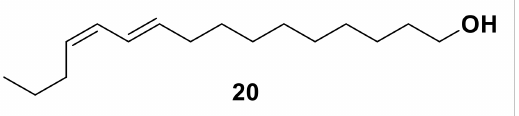
Figure 3. The chemical structure of Bombykol 20 , the first insect pheromone isolated from the silkworm moth, Bombyx mori